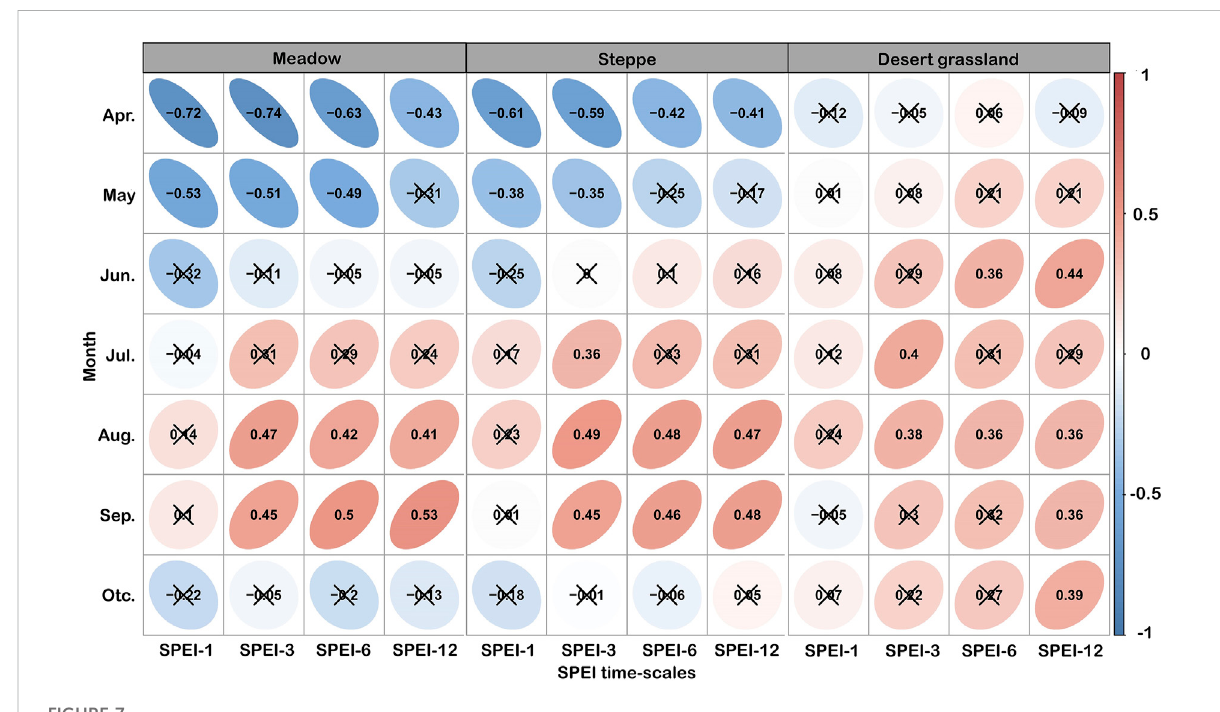
FIGURE 7 Correlation coef fi cients between the NDVI and SPEI at different time scales of meadow, steppe, and desert grassland in